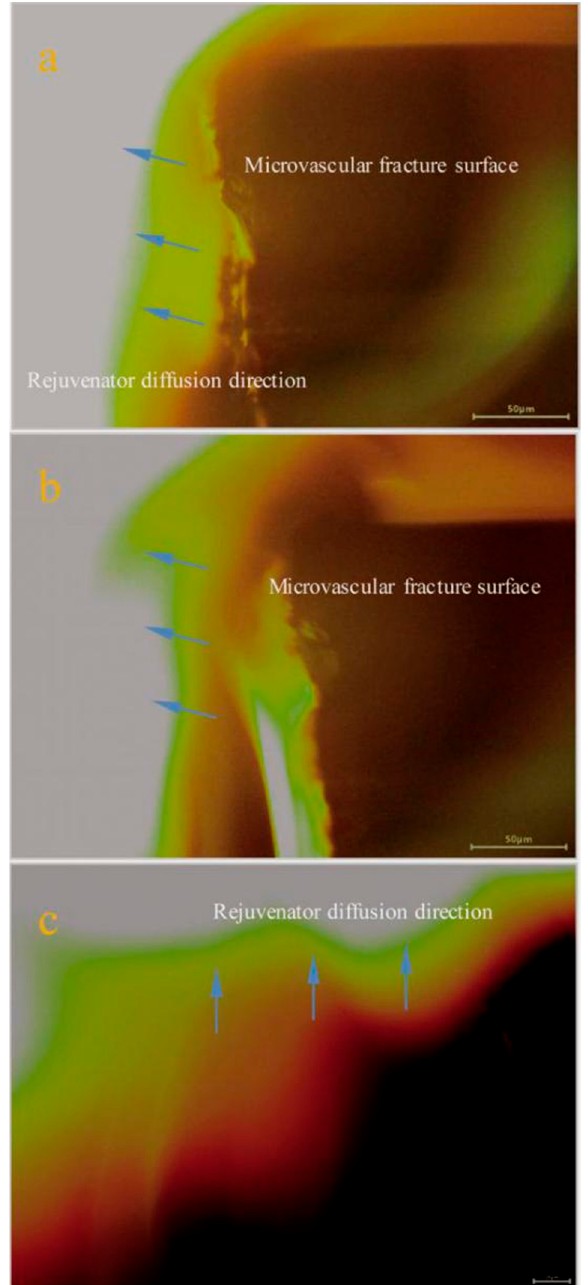
Figure 7. Fluorescence micrography of rejuvenator diffusion into asphalt sample during a self-healing process, ( a ) oily rejuvenator diffusion into asphalt from a fracture microvascular, ( b , c ) oily rejuvenator diffusion rapidly into an asphalt sample during 2 h and 4 h under 0 °C.